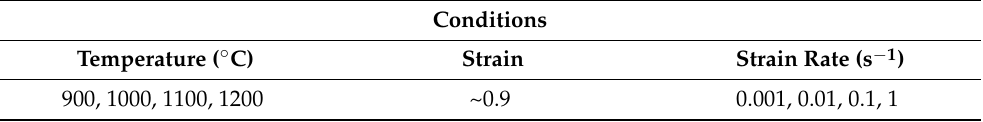
Table 2. Experimental parameters for the Gleeble